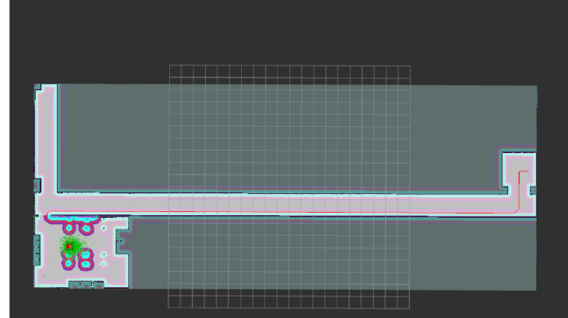
Figure 14. Global path plan.